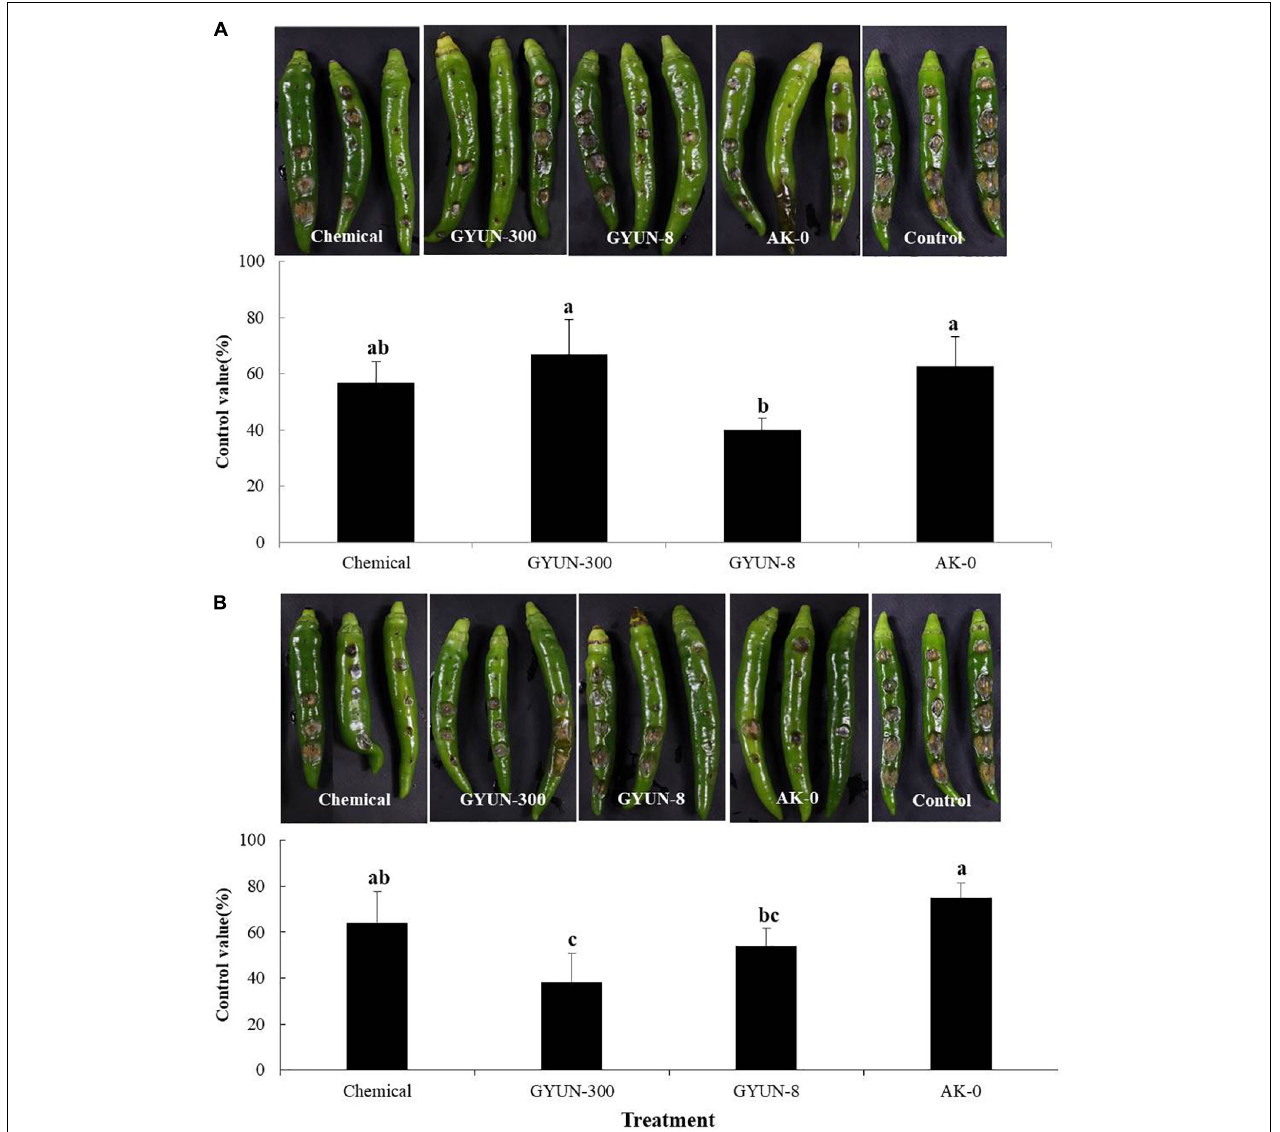
FIGURE 6 | Protective and curative effects of GYUN-300 on disease suppression of red pepper anthracnose in wounded fruits. (A) For protective effects, bacterial suspensions (10 7 CFU/mL) were sprayed on the detached green pepper fruits, followed by inoculation with Colletotrichum acutatum conidia suspensions (10 5 conidia/mL) on the same day. The disease severity (%) was recorded 10 days after incubation at 25 ◦ C. (B) For curative effects, symptom development was observed 10 days after pathogen inoculation with C. acutatum conidia suspensions (10 5 conidia/mL) on detached green pepper fruits, followed by treatment with bacterial suspensions (10 7 CFU/mL) using a spray method. Disease severity (%) was recorded 10 days after incubation at 25 ◦ C. The experiment was carried out two times with six replicates (fruits) per treatment, showing similar results. Bars with the same letters do not differ significantly between each other according to the least significant difference (LSD; p <